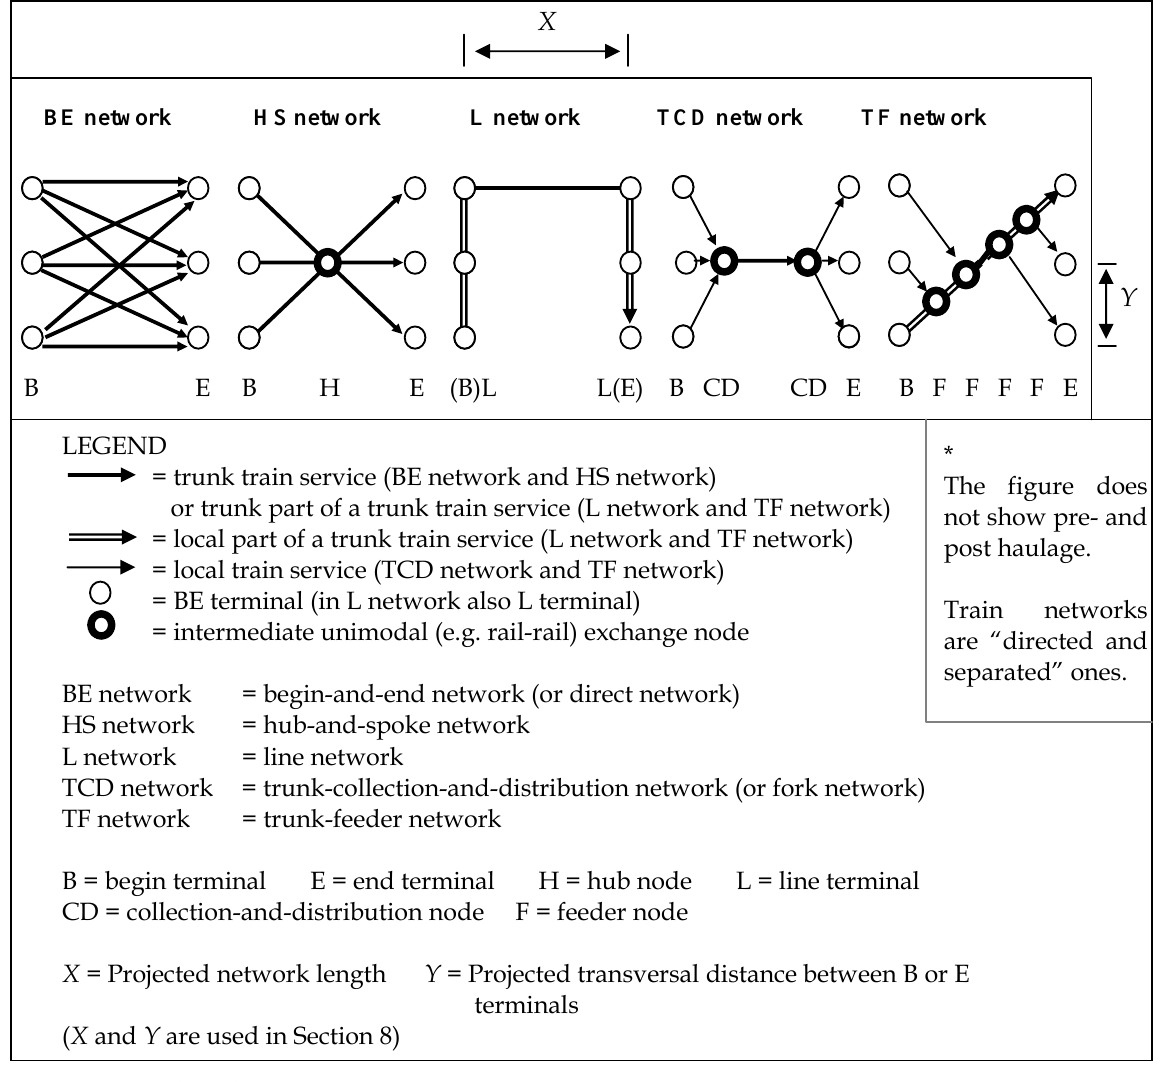
Figure 2. Basic bundling network